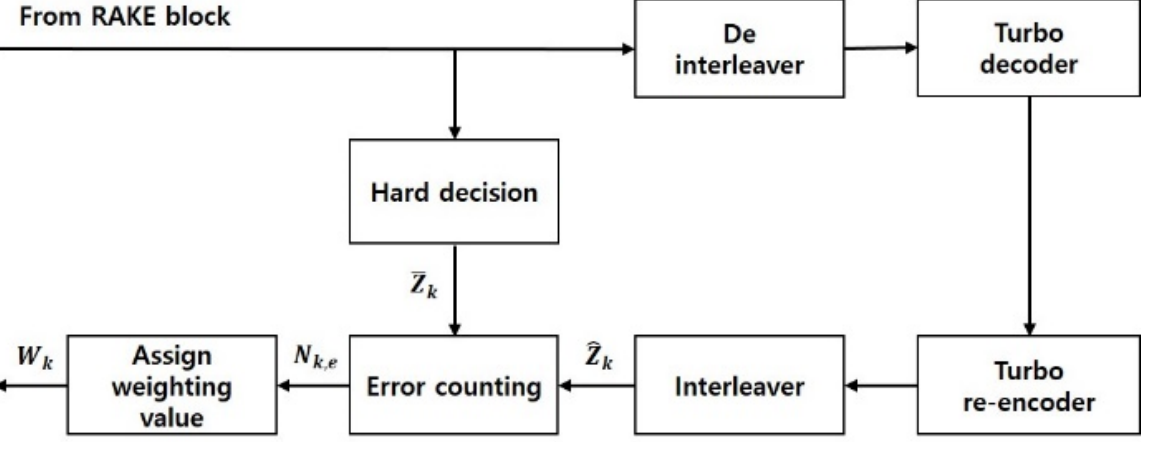
Figure 2. Block diagram of EC-BER block.